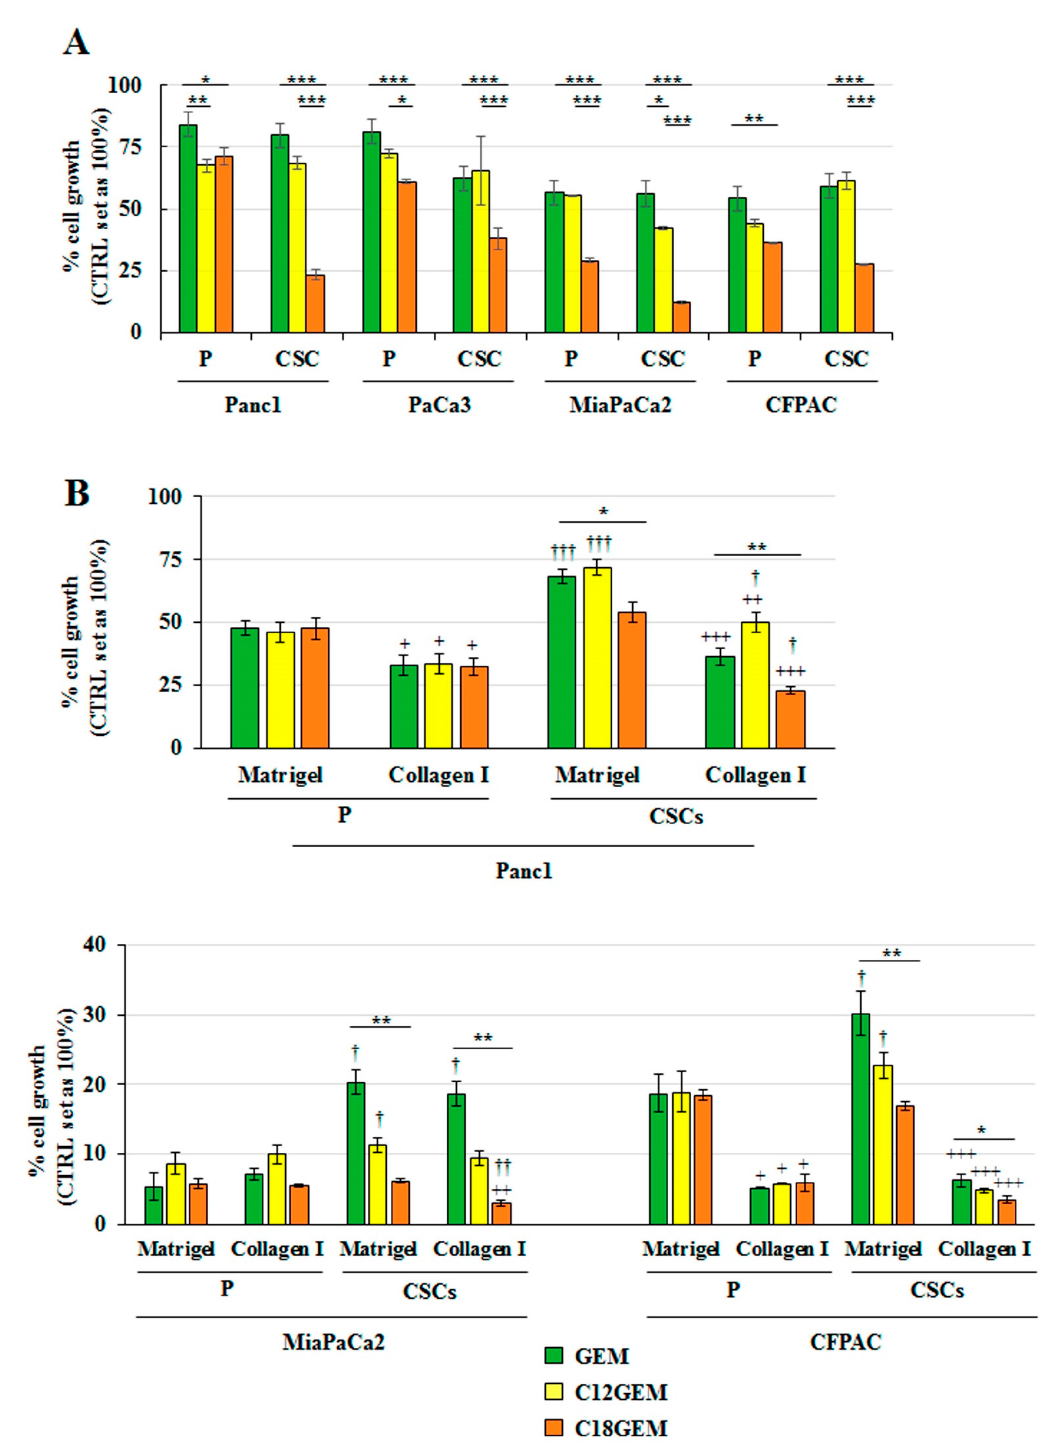
Figure 1. 4-( N )-stearoyl- Gemcitabine (C18GEM) is more effective than Gemcitabine (GEM) in the inhibition of pancreatic ductal adenocarcinoma cancer stem cells’ (PDAC CSCs) growth. Cell viability analysis of PDAC parental (P) cells and CSCs treated with 50 µ M of GEM or C12GEM, or C18GEM for 72 h in two-dimensional (2D) conditions ( A ) or for 7 days in Matrigel- and collagen I-rich extracellular matrix (ECM) ( B ). Cell viability was measured by Resazurin Cell Viability Assay Kit, as described in Materials and Methods. Values are the means ( ± SE) of at least three independent biological replicates. Statistical legend: p < 0.05 (*), p < 0.01 (**), or p < 0.001 (***), as indicated by bar in figure; p < 0.05 (+), p < 0.01 (++), or p < 0.001 (+++) collagen I versus Matrigel in each cell line for each drug; p < 0.05 (†), p < 0.01 (††), or p < 0.001 (†††) CSCs versus parental (P) cells in the two ECMs for each